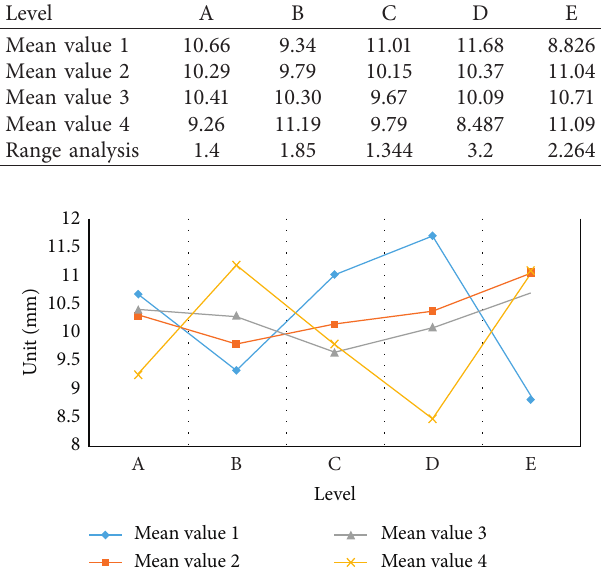
Figure 8: Warpage mean